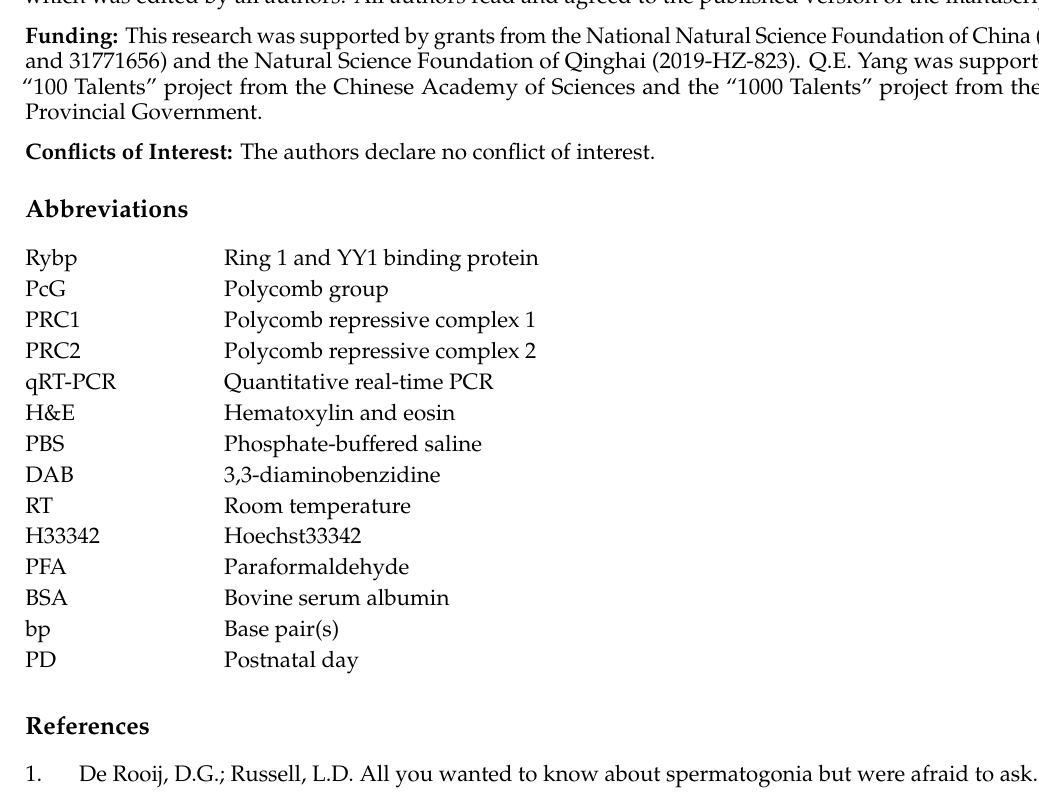
Table S1: PCR-related primer list, Table S2: Real-time PCR-related primer list, Table S3: Antibody Information in this